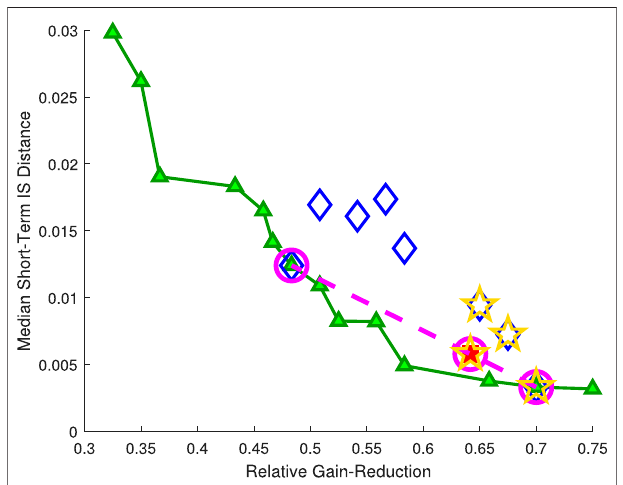
FIGURE 11 | Performance vectors, under the scenario of K = 6 and clean-signal (of the training stage), of the Pareto-front mic2-locations (connected green triangles), worst-case Pareto-front mic2-locations (blue diamonds), and the single-microphone solution (red square). The dashed-lineconnectedmagentacirclesdenotetheParetofrontthatconsiders the worst-case Pareto-front mic2-locations and the single-microphone solution. The gold pentagrams denote the performance vectors of the mic2- locations, chosen for the algorithm demonstration.